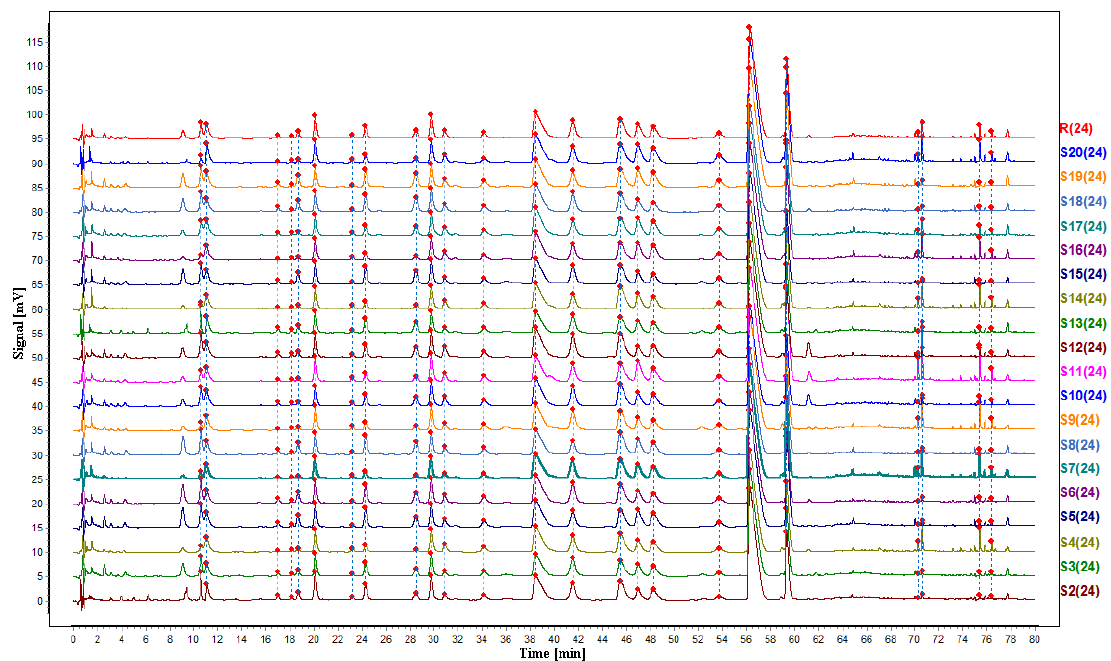
Figure 7. UHPLC fingerprints of different CR-EF herbal pair samples and reference fingerprint.